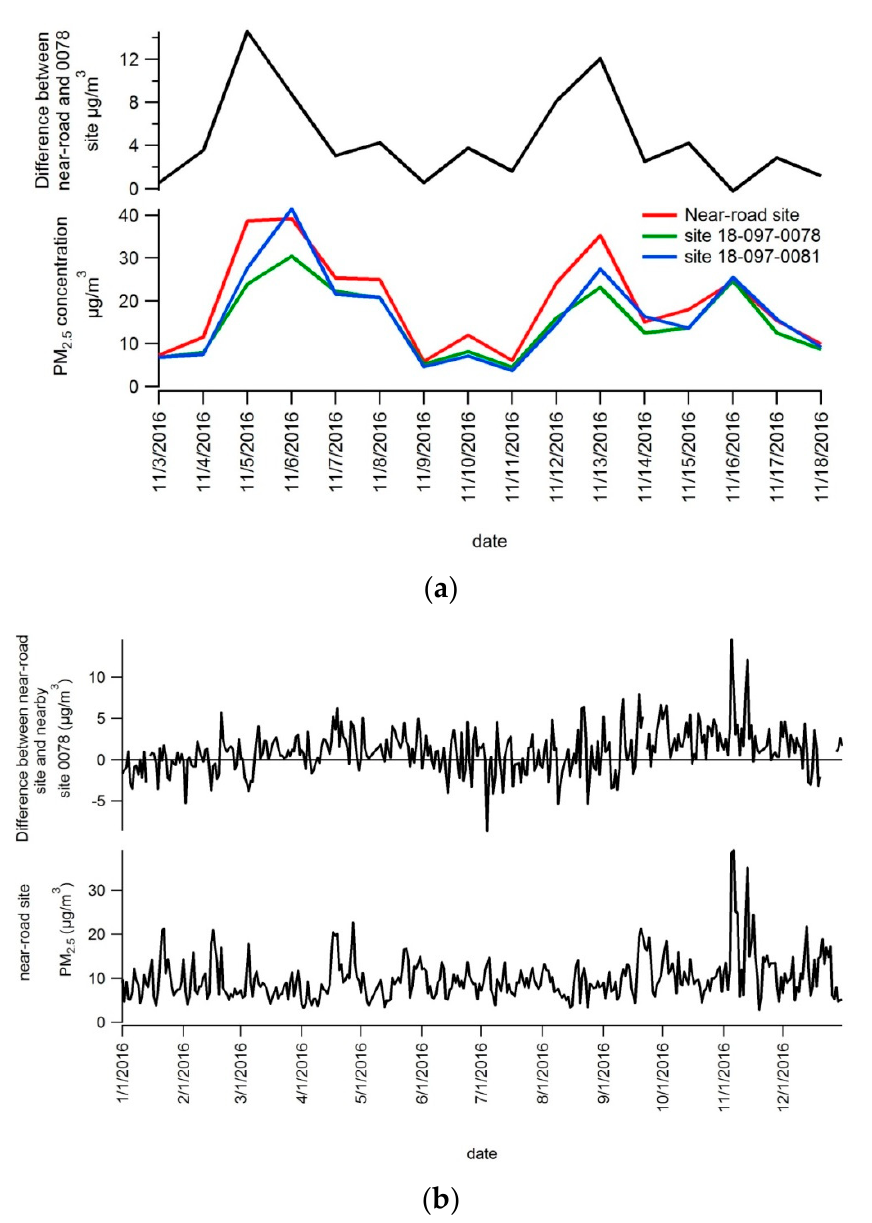
Figure8. Indianapolisnear-roadPM 2.5 increment. ( a )24-hPM 2.5 concentrationsattheIndianapolis-0087 near-road monitoring site and nearby sites (denoted by AQS ID) in Indianapolis from 3–18 November, 2016 (Washington Park, the background site, is 18-097-0078). Di ff erences in 24-h PM 2.5 concentrations between the near-road site and Washington Park (0078) are shown in the top panel. ( b ) 24-h PM 2.5 concentration at Indianapolis-0087 and nearby Washington Park 0078 in 2016. The di ff erence between these measurements is shown in the top